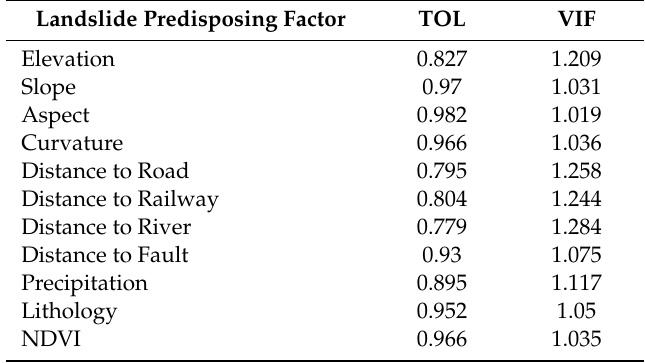
Table 2. Multicollinearity analysis for the landslide predisposing factors.